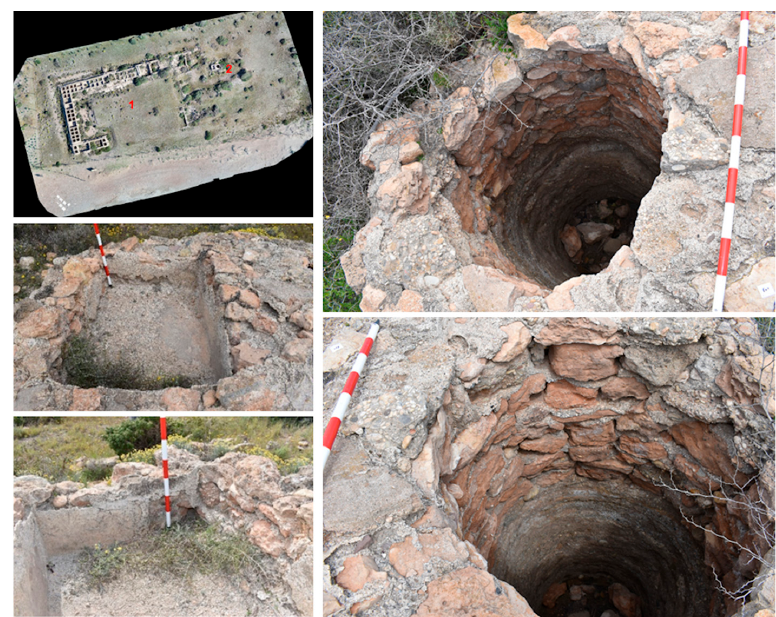
Figure 7. Elements of water supply: left side details of the lacus and right-side details of the well.